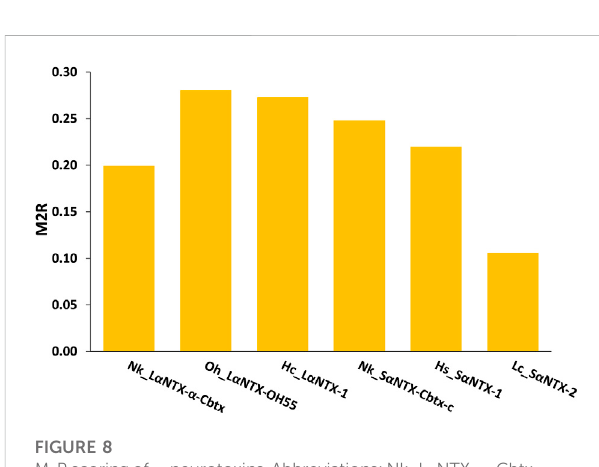
FIGURE 8 M 2 Rscoringof α -neurotoxins.Abbreviations:Nk_L α NTX- α -Cbtx, α -cobratoxin (UniProt ID: P01391, N. kaouthia ); Oh_L α NTX-OH55, long neurotoxin OH55 (UniProt ID: Q53B58, O. hannah ); Hc_L α NTX- 1, long neurotoxin 1 (UniProt ID: Q8UW29, H. curtus ); Nk_ S α NTX-Cbtx-c, cobrotoxin-c (UniProt: P59276, N. kaouthia );